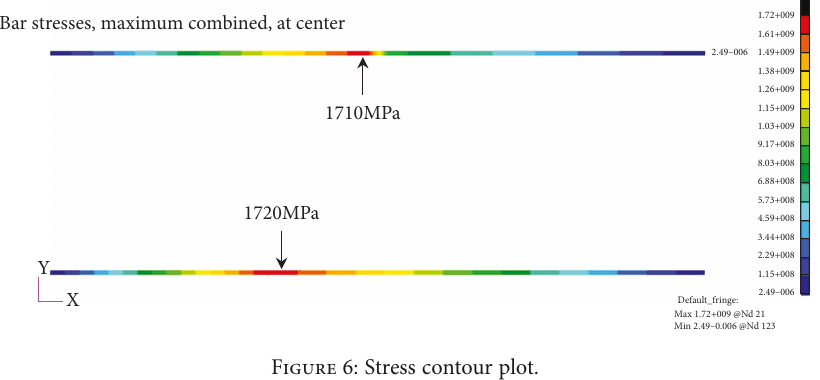
Figure 6: Stress contour plot.